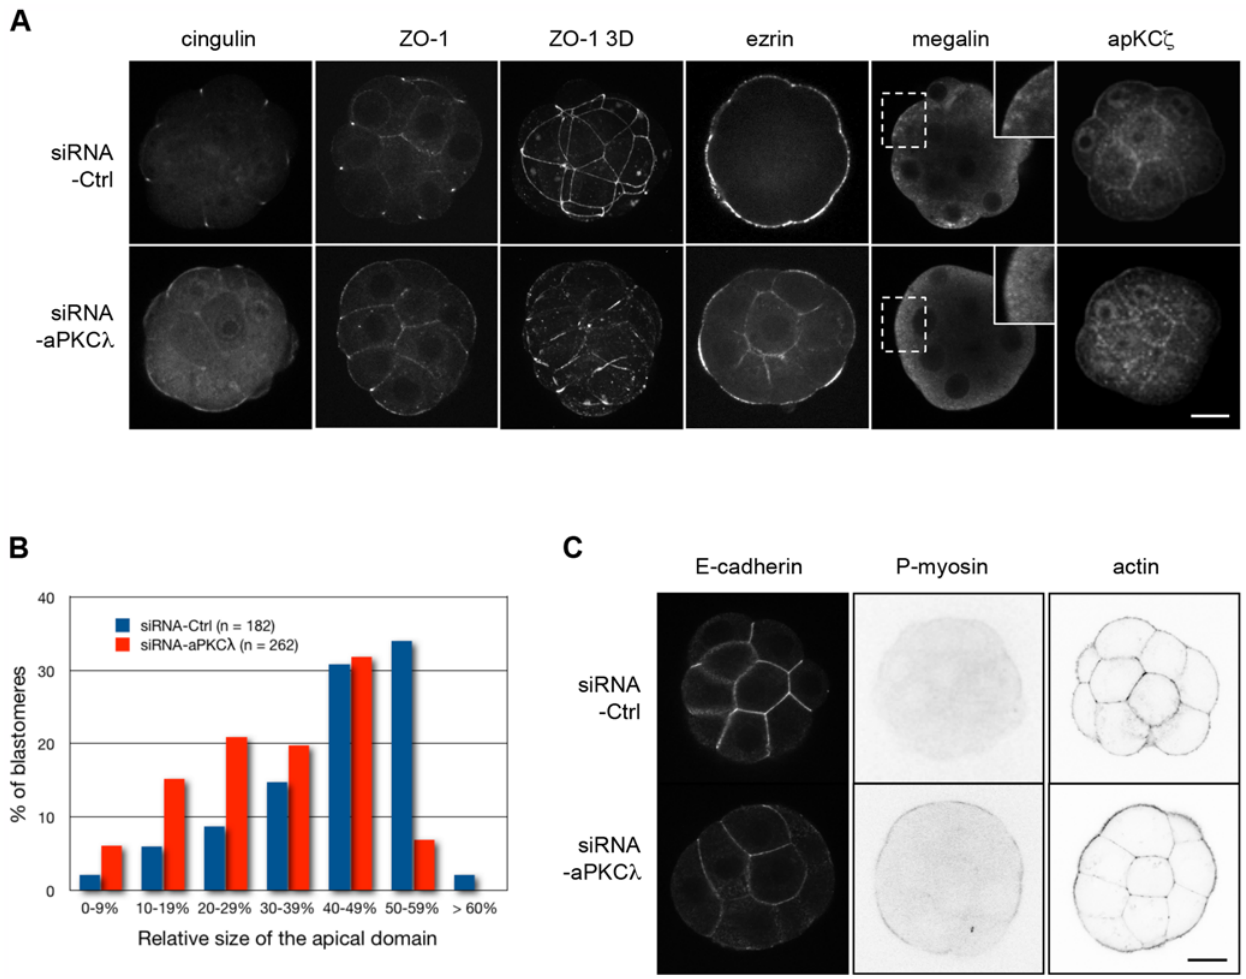
Figure 3. Abnormal cell polarity at the 16-cell stage in absence of aPKC l expression. (A): Confocal microscope analysis of cingulin (27 embryos), ZO1 (34 embryos), ezrin (39 embryos), megalin (9 embryos), and aPKC f (28 embryos) in control siRNA (siRNA-Ctrl) or siRNA-aPKC l injected embryos. Figures ZO1-3D represent projections of 30 confocal sections to visualize the belt-like staining of ZO1. siRNA-Ctrl or siRNA-aPKC l were microinjected at the 2-cell stage. Scale bar: 20 m m. (B): Measure of the apical surface in control (blue bars) and in aPKC l -depleted (red bars) blastomeres. The measure represents the percentage of the apical membrane relative to the whole plasma membrane. The difference between the two groups is highly significant (p , 0.0001). (C): Confocal microscope analysis of E-cadherin (32 embryos), phospho-myosin (37 embryos), and actin (49 embryos), at the 16-cell stage in control-siRNA (siRNA-Ctrl) or siRNA-aPKC l injected embryos. siRNA-Ctrl or siRNA-aPKC l were microinjected at the 2-cell stage. Scale bar: 20 m